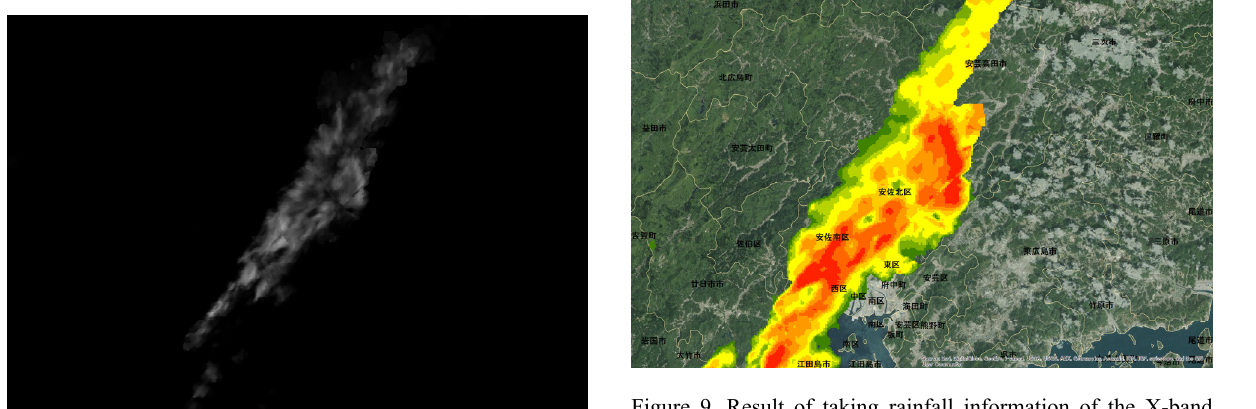
Figure 9. Result of taking rainfall information of the X-band MP radar into GIS (2014.08.20 2:00).